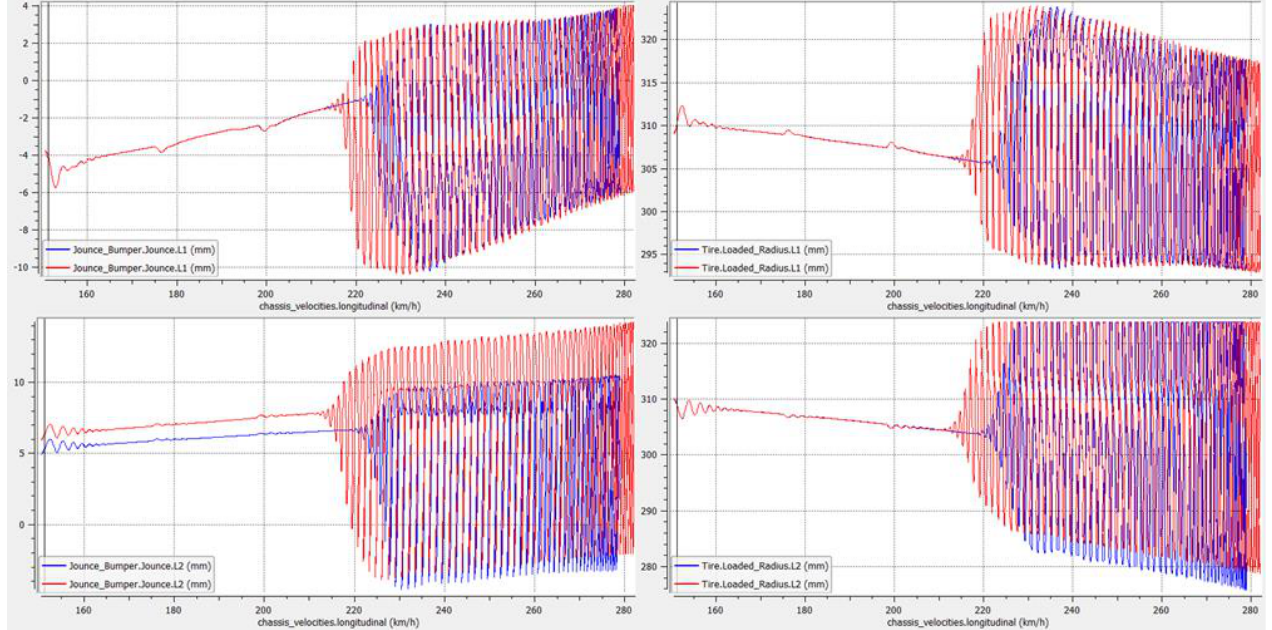
Figure 23. Rear suspension jounce amplitude (on the left for front and rear axle) and the delay in terms of speed are the only significant effects of a stiffer bump stop at the rear end (blue plot as always).